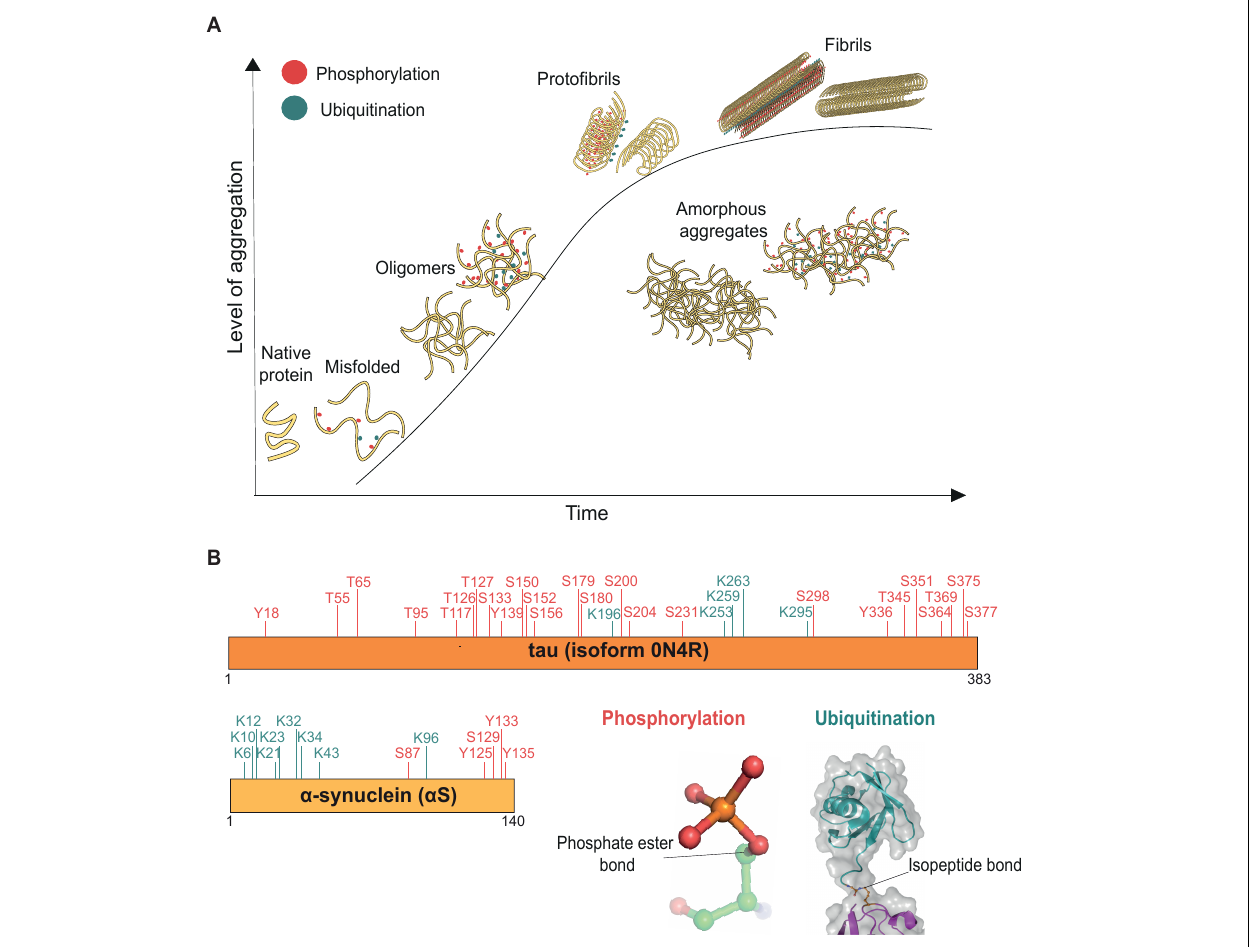
FIGURE 1 | Aggregation process (time) of misfolded proteins. (A) Schematic representation of protein aggregation over time. The aggregation process (time) is represented by the x -axis, and the y -axis reflects the level of accumulated aggregates. Misfolded proteins deviate from their native conformations and start to assemble into oligomers ( ∼ 20–200 nm, Lobanova et al., 2021), mostly globular in shape. The initiation of the aggregation process may occur in conjunction with post-translational modifications, such as phosphorylation (red) and ubiquitination (cyan). As aggregation progresses, additional misfolded proteins accumulate and aggregates grow in size. Eventually structural rearrangements occur within the aggregates such that misfolded proteins start to organize into the ordered manner observed in protofibrils. Stable filamentous aggregates (fibrils) form from these highly ordered arrangements of misfolded proteins, now no longer soluble in their native environment. The various forms of aggregated proteins may sometimes assemble into amorphous aggregates, which have no distinct shapes and in which the individual misfolded proteins are not considered to have any ordered arrangements. (B) Both tau and α -synuclein ( α S) are known to be post-translationally modified, shown here are the phosphorylation (red) and ubiquitination (cyan) sites identified by mass spectrometry in donor brain tissues of Alzheimer’s and Parkinson’s disease, respectively (Park et al., 2018; Zhang et al., 2019). Cartoon inserts detail molecular features of the covalent linkages associated with phosphorylation (pdb-id 4WZP) and ubiquitination (pdb-id